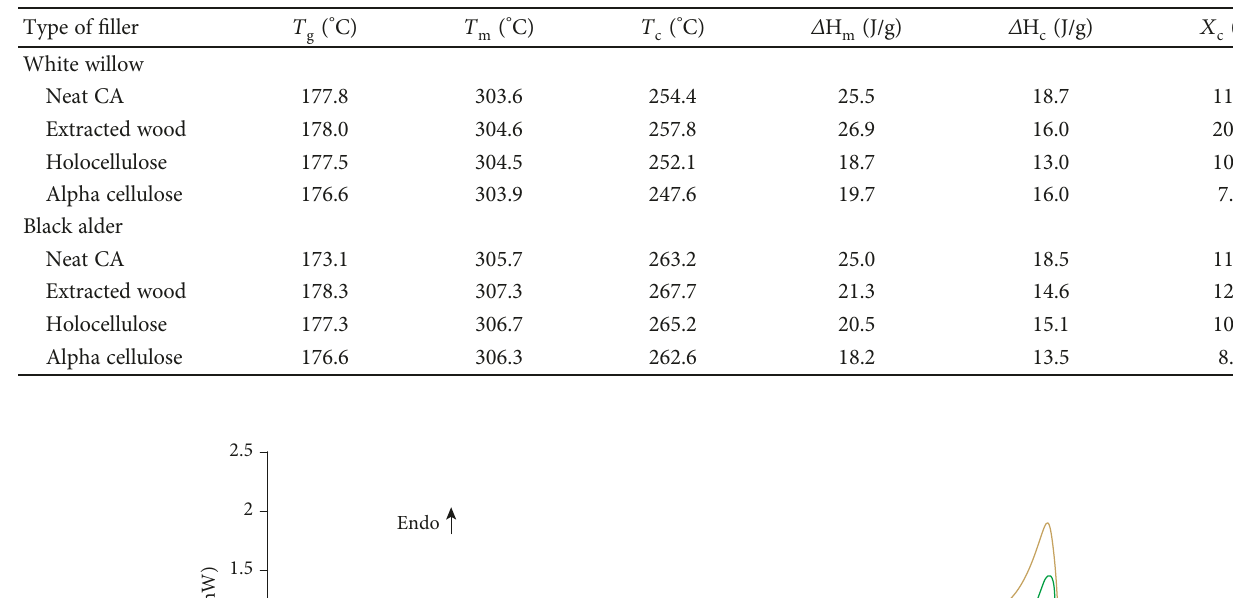
Table 4: DSC analysis of biocomposite materials.